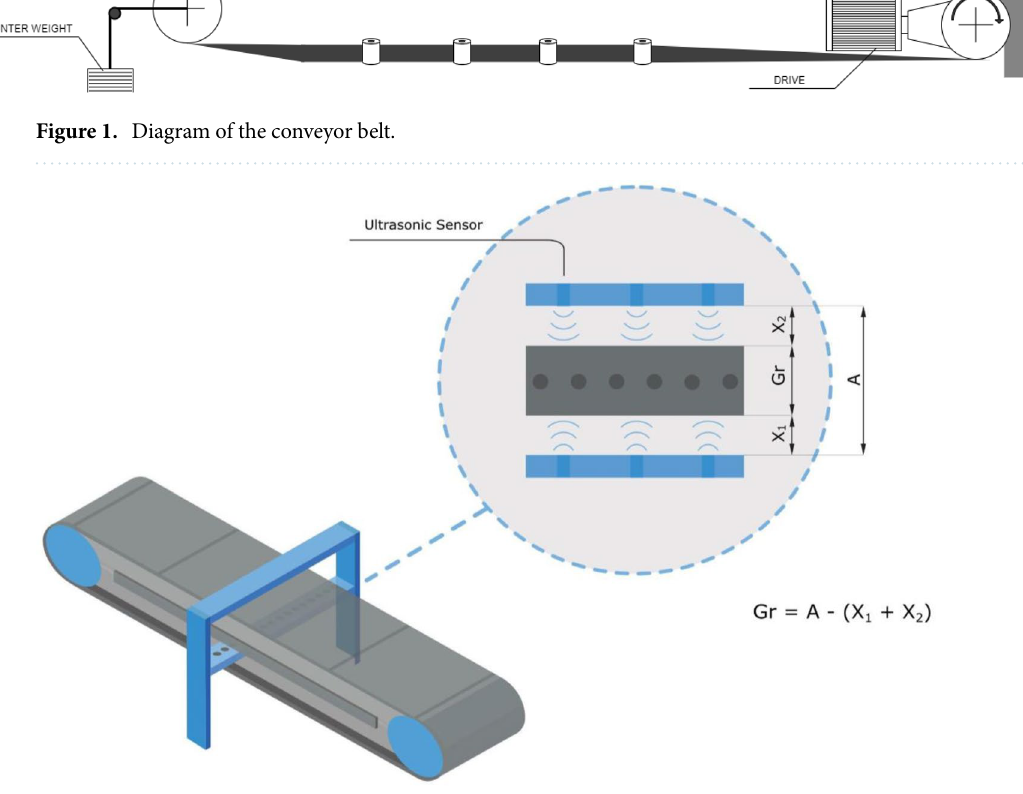
Figure 2. The idea of differential measurement 28